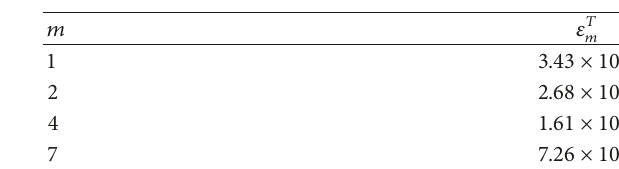
Table 1: The total residual square error 𝜀 𝑇 𝑚 for different approxima- tion order 𝑚 with 𝑐 0 = −0.95